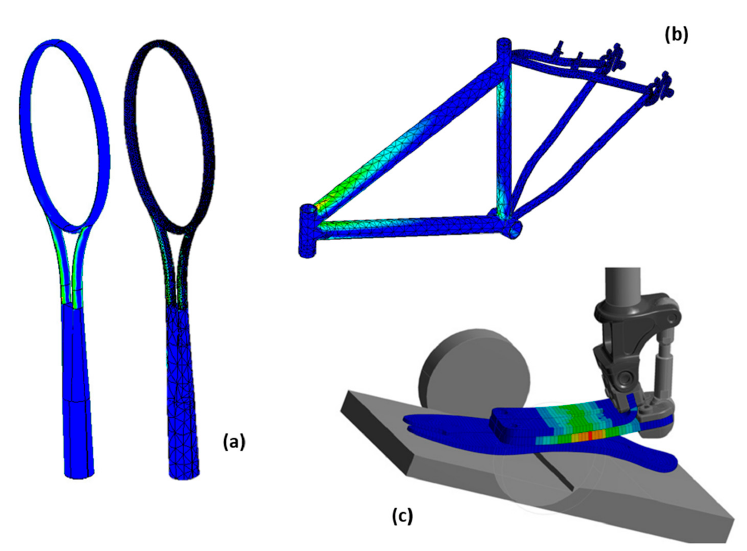
Figure 45. Some applications of FEM for composites in the sport sector: ( a ) a tennis racket, ( b ) a bicycle and ( c ) a prosthetic. Reproduced with Creative Common License [331].